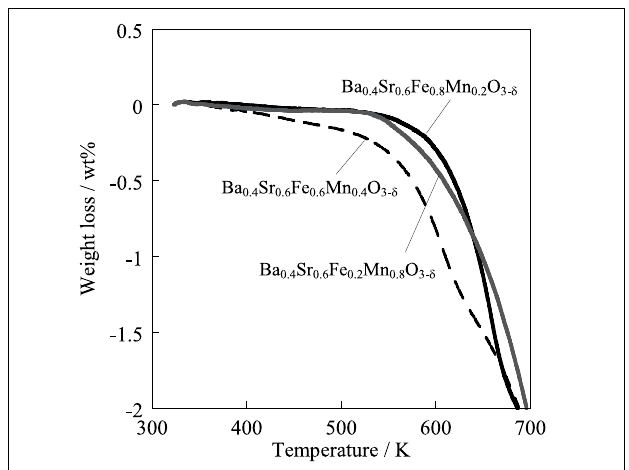
FIGURE 8 | Reduction behavior of Ba 0 . 4 Sr 0 . 6 Fe y Mn 1 − y O 3 − δ ( y = 0 . 2, 0.6, 0.8) catalysts under 10 vol% H 2 atmosphere.